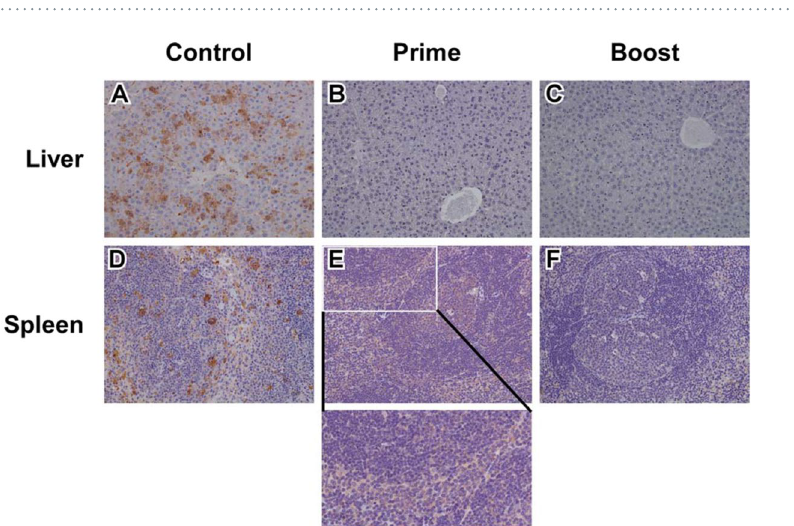
Figure 6. Immunohistochemistry of mice tissues. Representative study endpoint liver tissue sections for the control ( A ), prime ( B ), and boost ( C ) cohorts with observable marked CCHFV immunolabeling of hepatocytes in the control group ( A ) and no observable labeling in the prime ( B ) or boost ( C ) cohorts. Representative study endpoint spleen tissue sections for the control ( D ), prime ( E ), and boost ( F ) cohorts with observable marked CCHFV immunolabeling in mononuclear cells ( D ), cytoplasmic, mild, and diffuse immunolabeling of mononuclear cells primarily in the red pulp ( E , inset), and no specific CCHFV immunolabeling in the boost cohort ( F ). Original magnification of all panels,